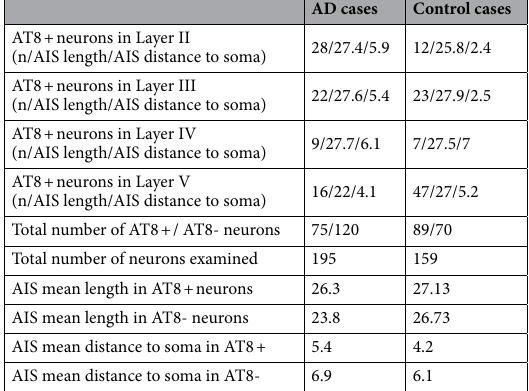
Table 2. Table showing the number of neurons and mean values for AIS length and AIS distance to soma in AT8-immunopositive or AT8-immunonegative in the different cortical layers in each case. Length and distance are expressed in µm. Mean values are calculated considering all individual